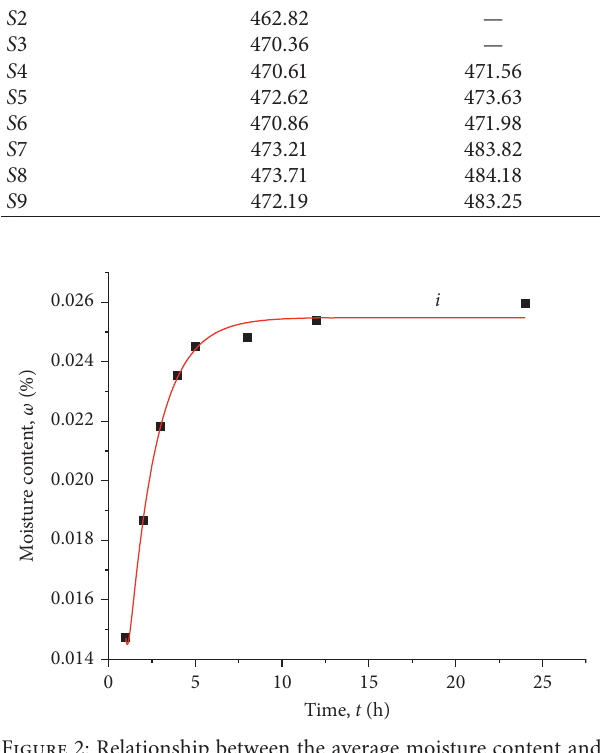
Figure 2: Relationship between the average moisture content and the wetting